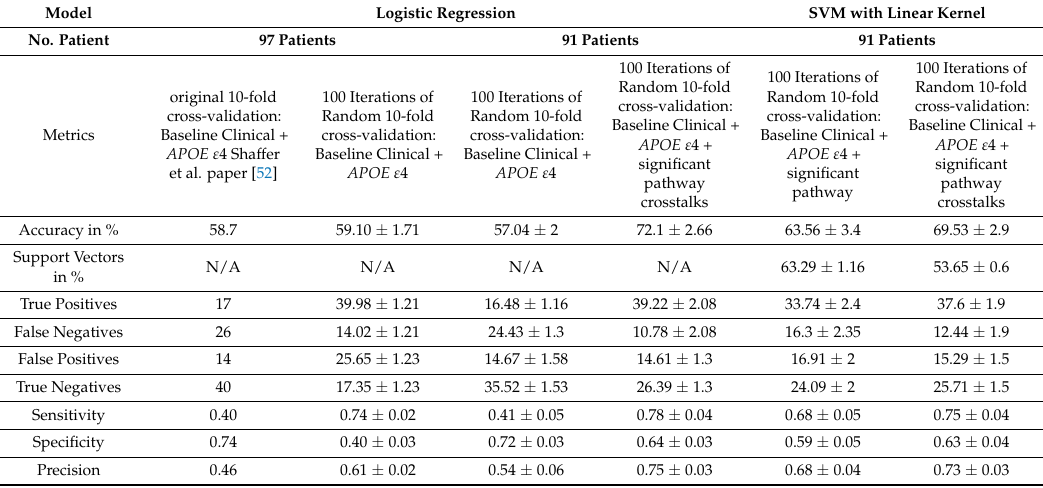
Table 4. Performance of Shaffer et al. [52] model with clinical parameters with 97 patients in comparison to our model with 97 and 91